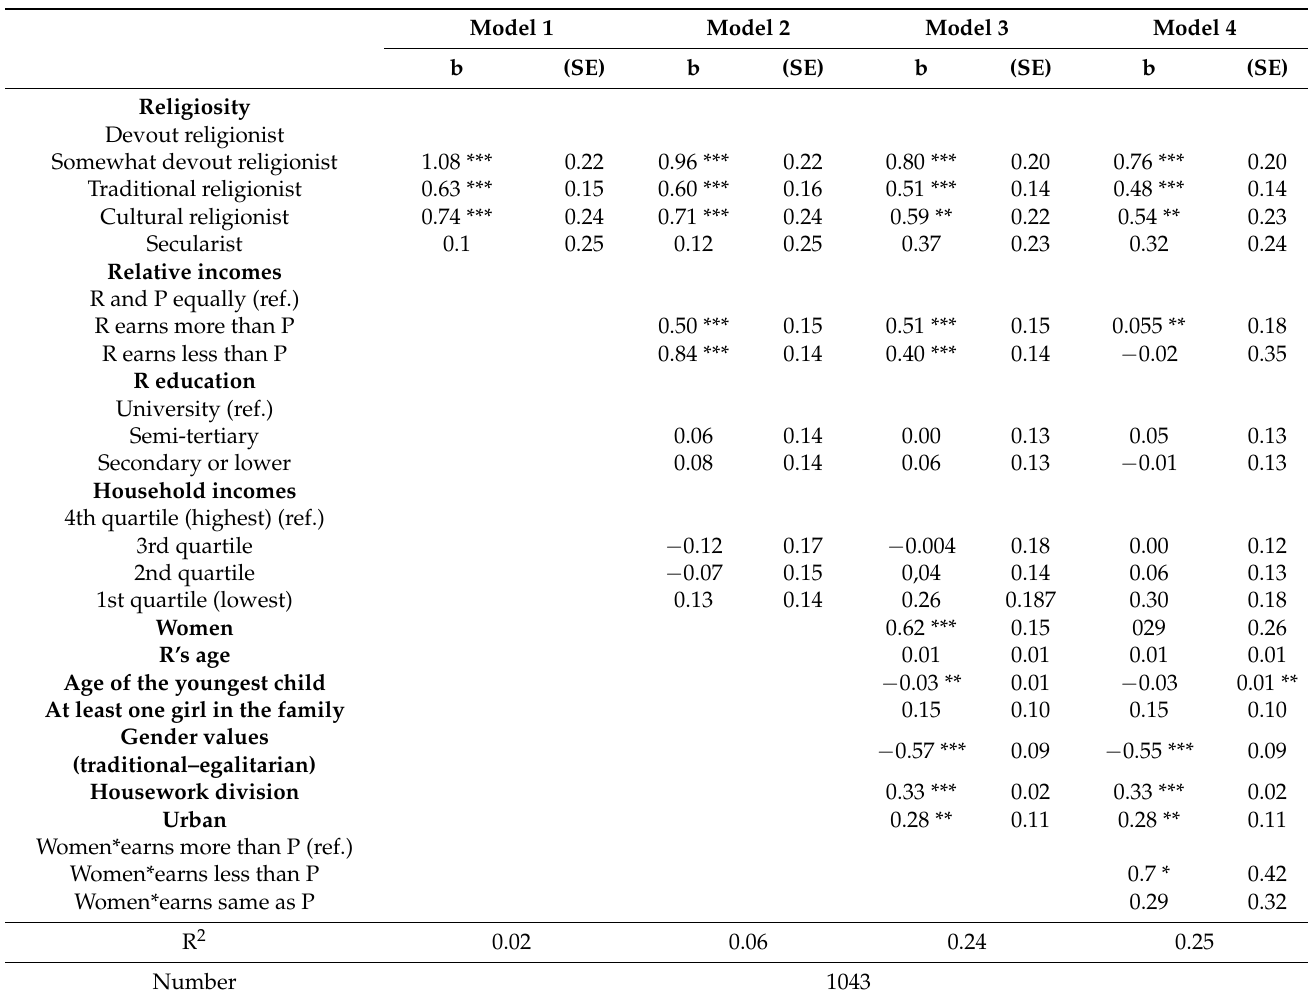
Table 2. Multivariate regression results for childcare task division (egalitarian–traditional), unstandardized b and standard